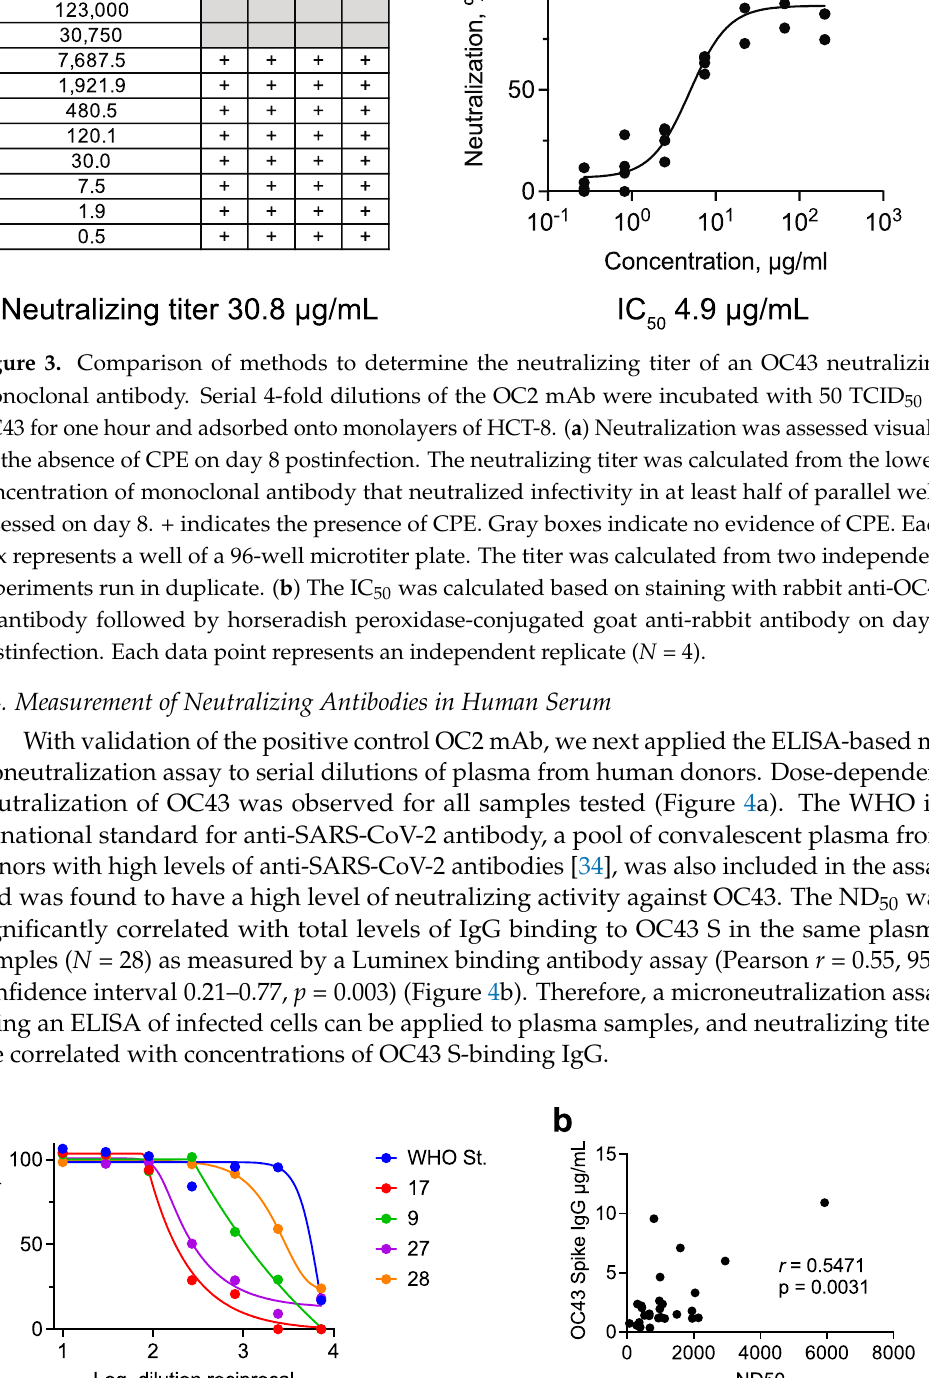
layers of HCT-8. The neutralizing titer was calculated based on staining with rabbit anti-OC43 N antibody followed by